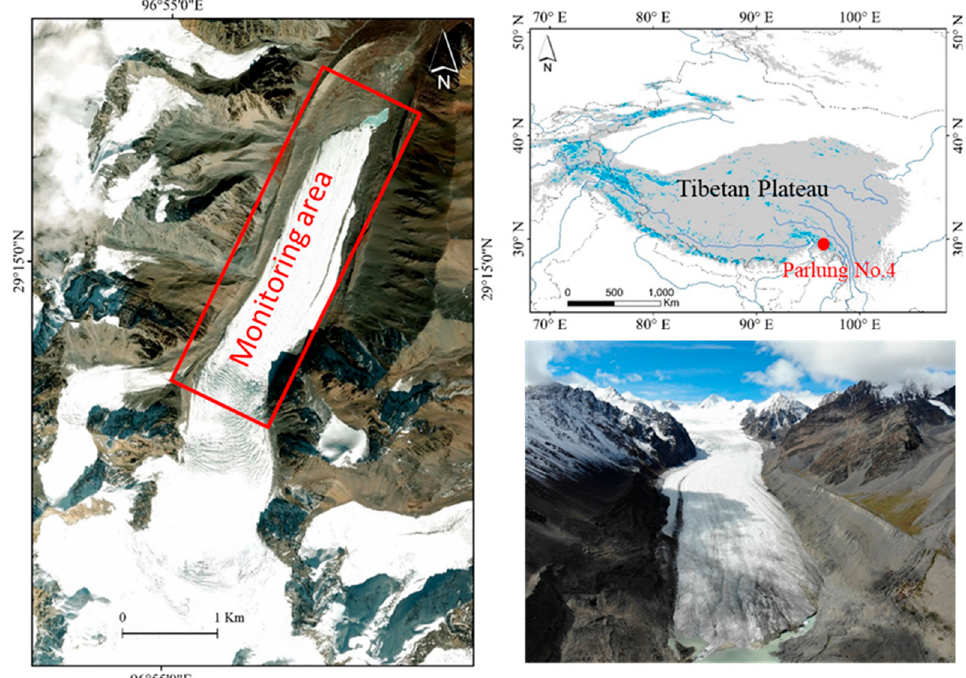
Figure 1. Location of Parlung No. 4 Glacier in the southeastern Tibetan Plateau and the extent of the UAV survey area (red rectangle), with field photos taken in 2019.